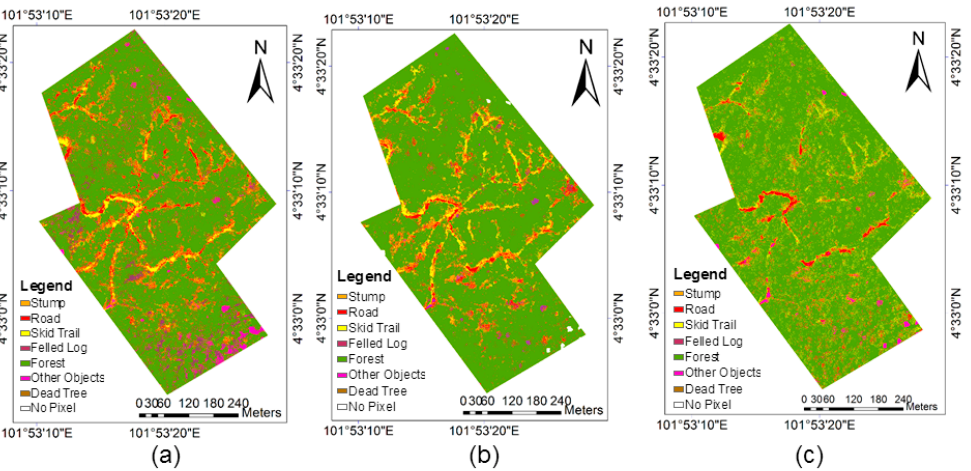
Figure 14. Maps of conventional classifications using three different methods: ( a ) Mahalanobis distance; ( b ) maximum likelihood; ( c ) minimum distance. Table 6. Overall accuracy and kappa coefficients from the